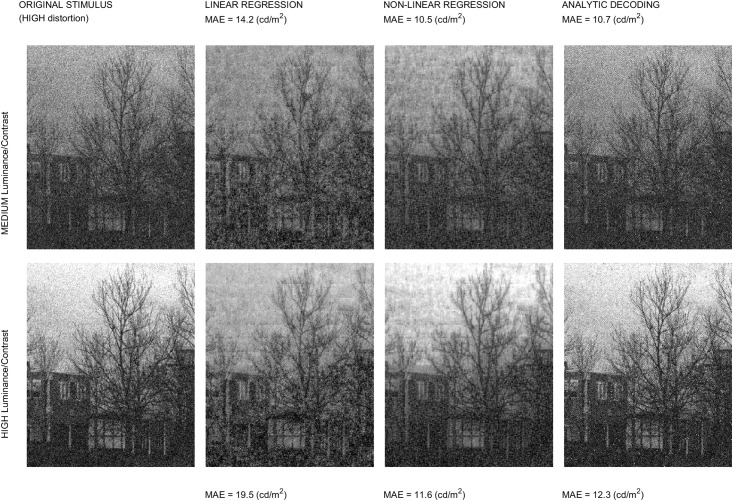
Reconstructions in the high-distortion regime.These six reconstructions correspond to the highlighted dots in the surfaces at the right plot of Fig 13. In this example, with decoders properly trained in the high-distortion regime, the analytic decoding does not have the best MAE values (MAE is not a visually meaningful measure anyway), but it is certainly better in preserving the visual structures in the scene.